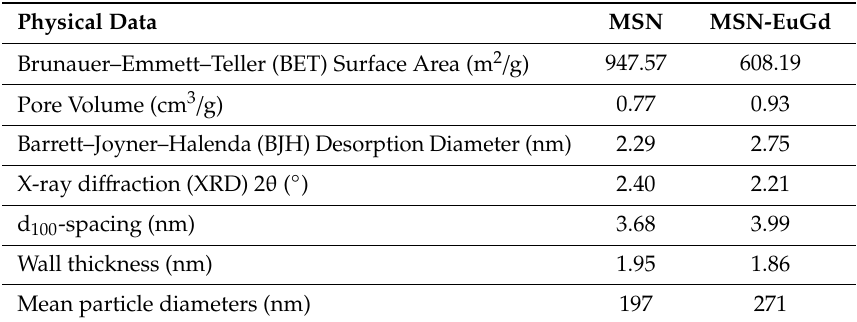
Figure 1. ( a ) Small-angle X-ray powder diffraction (XRD) analysis of mesoporous silica nanoparticles (MSN) and MSN-EuGd, ( b ) isothermal nitrogen adsorption of MSN and MSN-EuGd, ( c ) and ( d ) analysis of MSN structure and size using transmission electron microscopy (TEM). Scale bar: ( c ) 20 nm, ( d ) 0.5 µ m. Table 1. Properties analysis of mesoporous silica nanoparticles (MSNs) and MSN-EuGd.